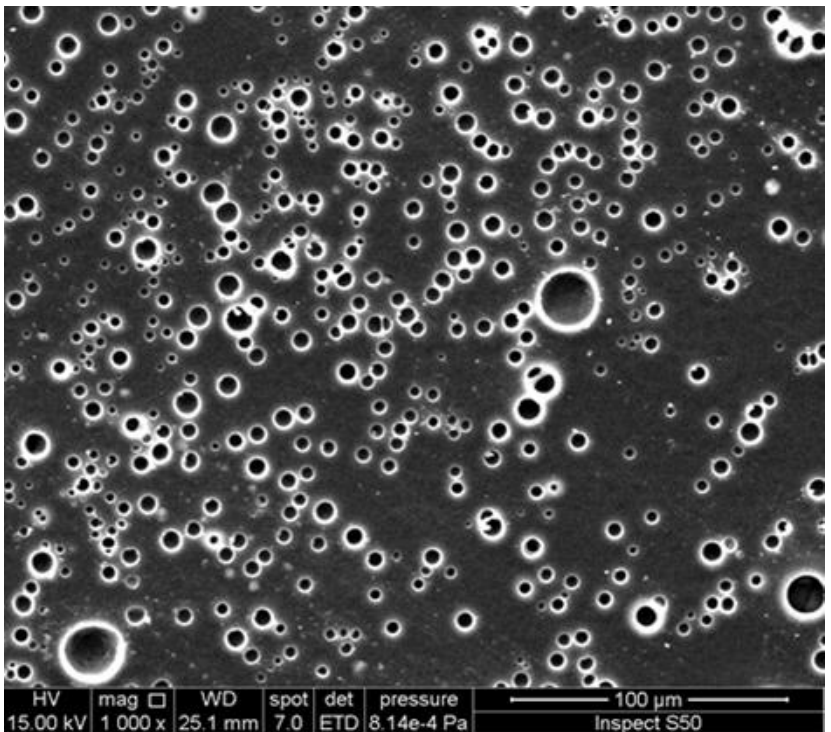
Figure 11. SEM image of the surface of an irradiated PS film blended with a Schiff base of biphenyl- 3, 3′ ,4, 4′ -tetraamine.